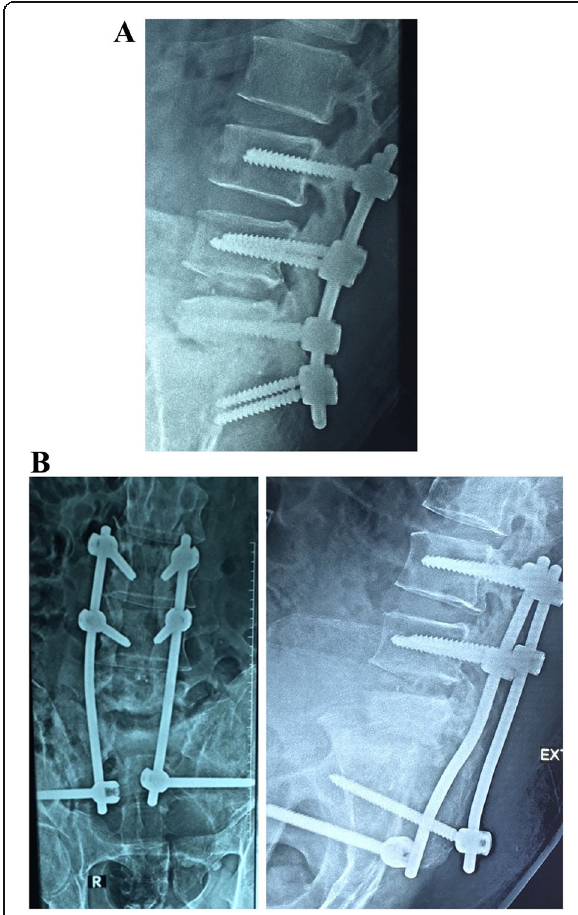
Fig. 6 a Three years postoperative lateral view plain X-ray image of a 65-year-old diabetic male patient operated for lumbosacral fixation, showing the signs of L5-S1 discitis and hardware failure in the form of sacral screw pull out. b Six months postoperative plain X-ray AP and lateral views of the lumbosacral spine region after removal of the old hardware and insertion of a new hardware from L3 down to the pelvis escaping the L5 and S1 bodies due to the bad bone quality and the excessive osteolytic reaction associated with the infective process. Note the pull out of the pelvic screw and rod loosening